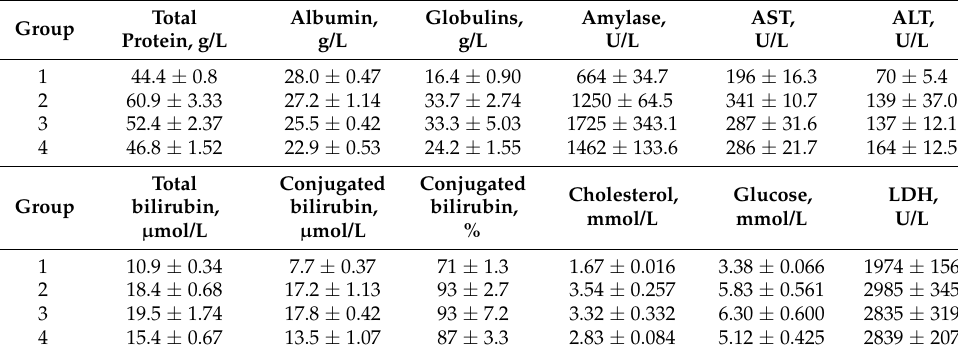
Table 1. Biochemical blood test of experimental